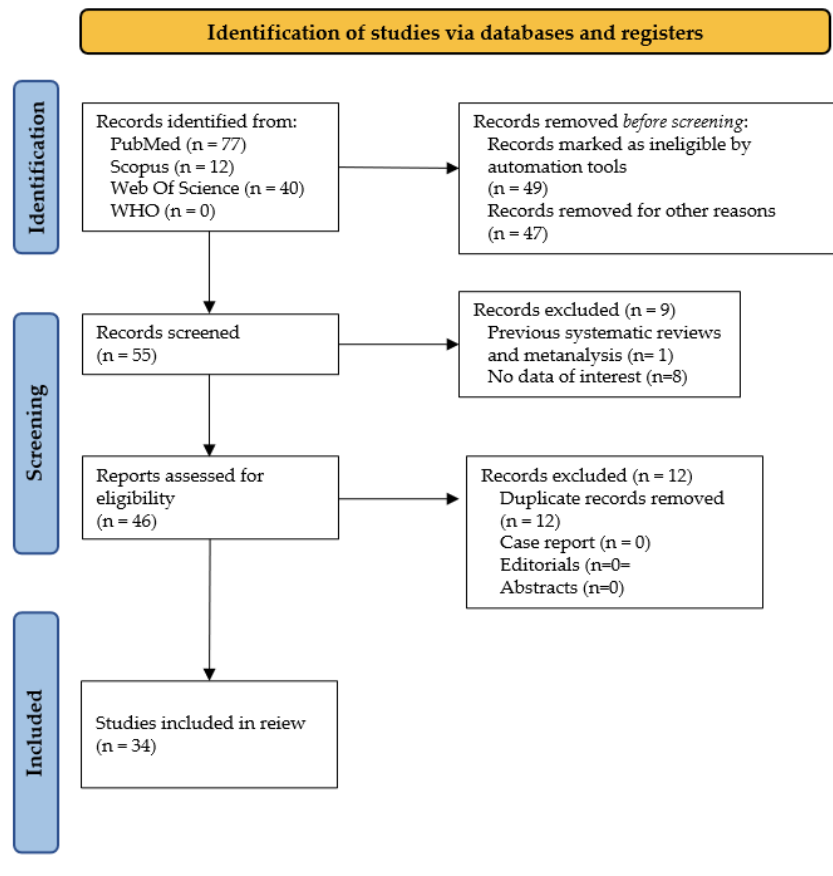
Figure 1. PRISMA flowchart. Table 1. Key results. Y., years; N.S., not specified.